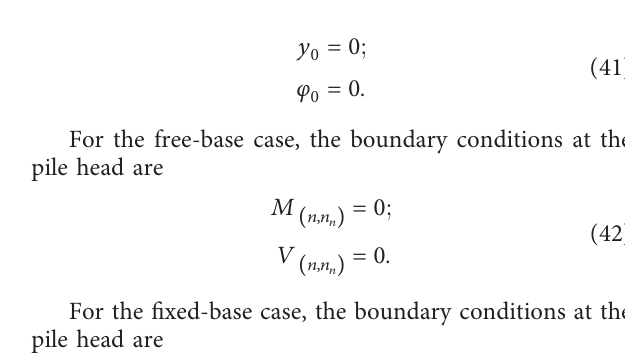
Figure 7: Diagram of the SX Bridge. (a) Plane location of SX Bridge. (b) Sectional view of SX Bridge.